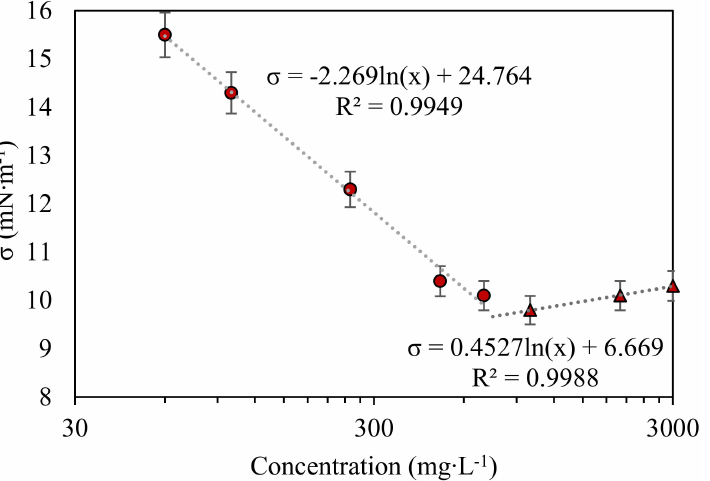
Figure 6. Interfacial tension ( σ ) for the critical micelle concentration (CMC) determination at different concentrations of AGC. Measurements made at 25 ◦